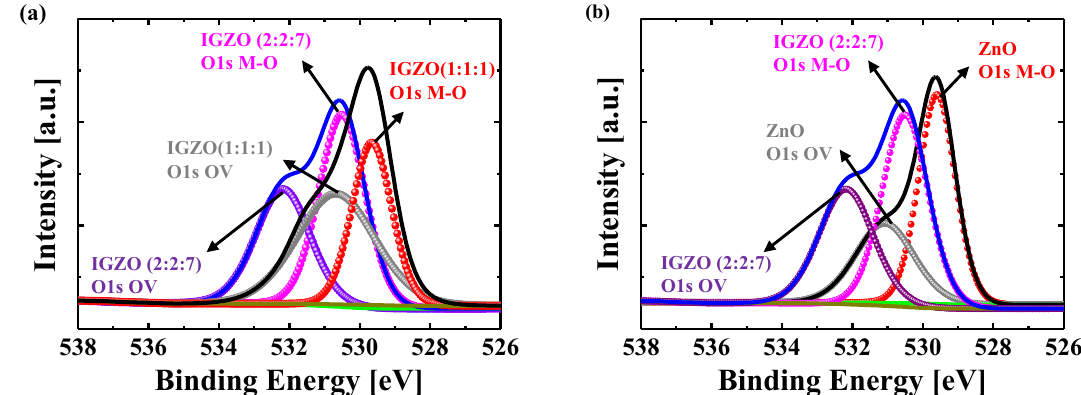
Figure 5. X-ray photoelectron spectroscopy spectra of O1s ( a ) a single IGZO and ( b ) bi-layer IGZO/ZnO memristors. The proportions of the oxygen vacancy peaks (O1) of the high-resistance state for a single IGZO and bi-layer IGZO/ZnO memristors are 45.2% and 38.2%, respectively, while that of LRS for both memristors is about 43.4%.